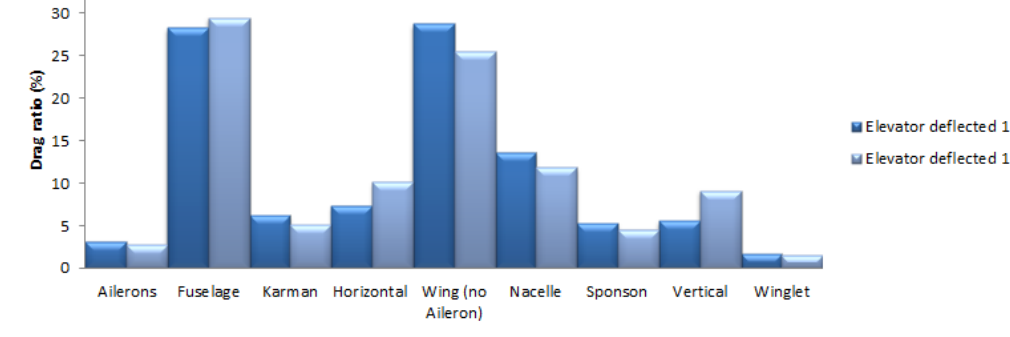
Figure 27. Drag breakdown for the whole aircraft with deflected